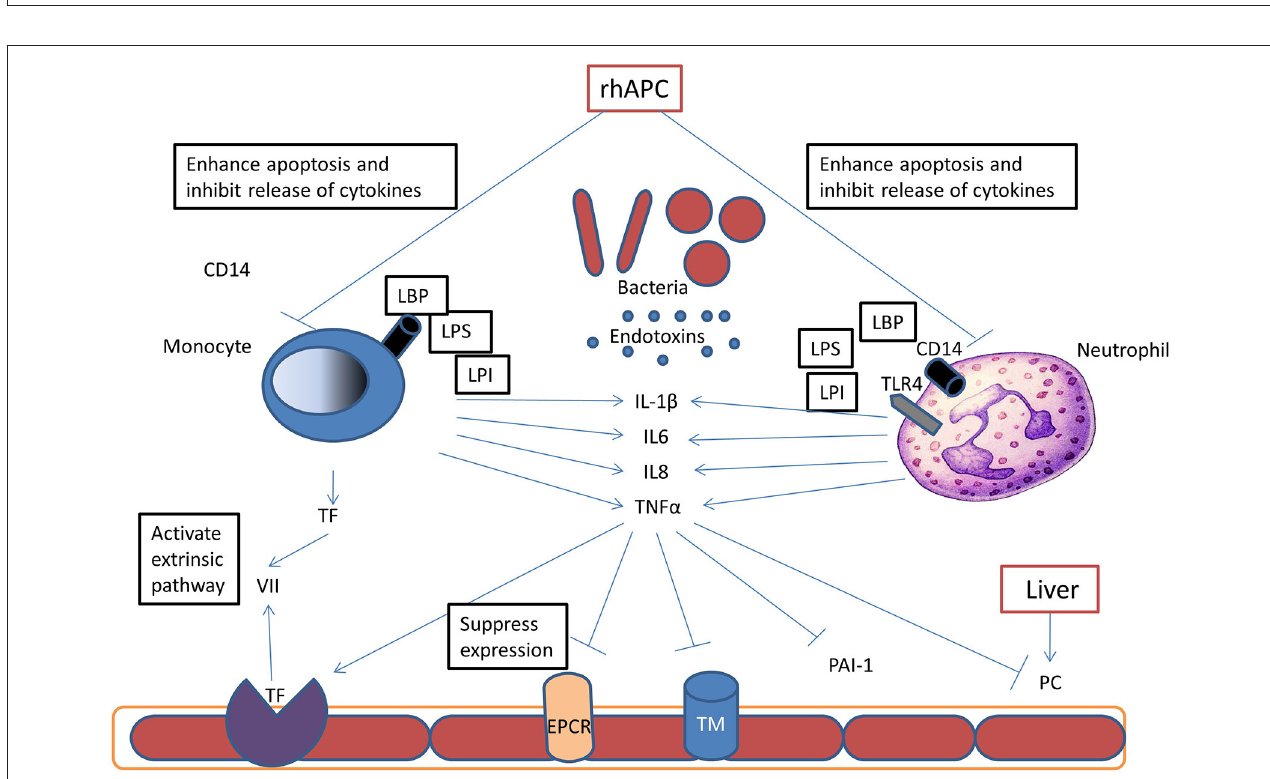
FIGURE 2 | Pathophysiology of Protein C in Sepsis: during sepsis, bacteria release endotoxins (LPS, LPI, LBP), these endotoxins bind to different receptors on neutrophils and monocytes and stimulate inflammatory cytokine release. These cytokines promote thrombin generation by upregulation of tissue factor (TF) expression on monocytes and endothelium. Inflammatory cytokines also inhibit protein C synthesis in the liver and reduce thrombomodulin (TM) and endothelial protein C receptor (EPCR) expression, and thereby inhibit APC formation. Recombinant human activated protein C (rhAPC) enhances neutrophils and monocytes apoptosis and therefore inhibits cytokines release and reducing tissue